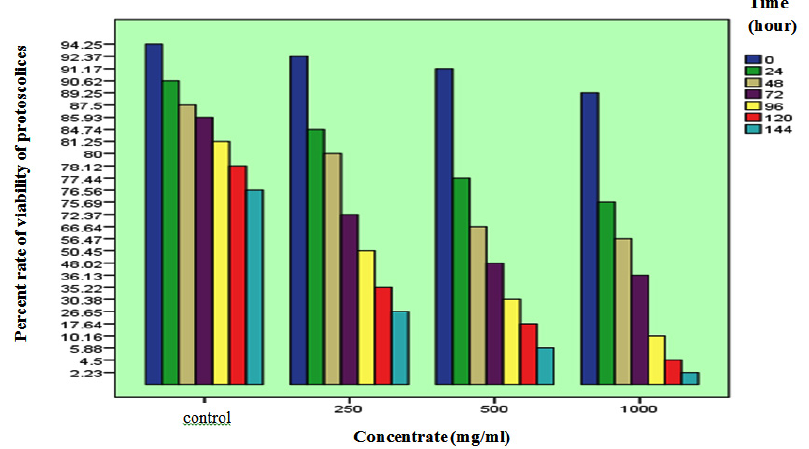
Fig. 9. Effect of albendazole concentrations (1000,500,250) mg/ml in the viability of exogenous primates-